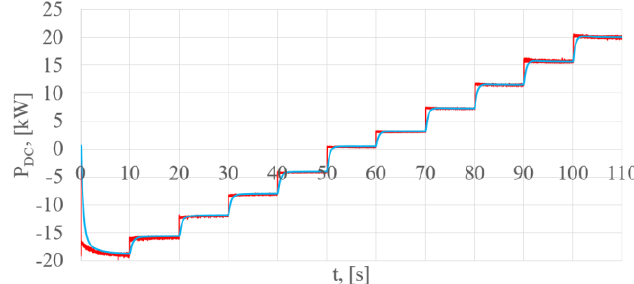
Fig. 11. The second case: constant power steps throughout the motor drive system’s power range. Measurements from the novel DC power meter (red line) and the N4L PPA5530 power analyzer (blue line).